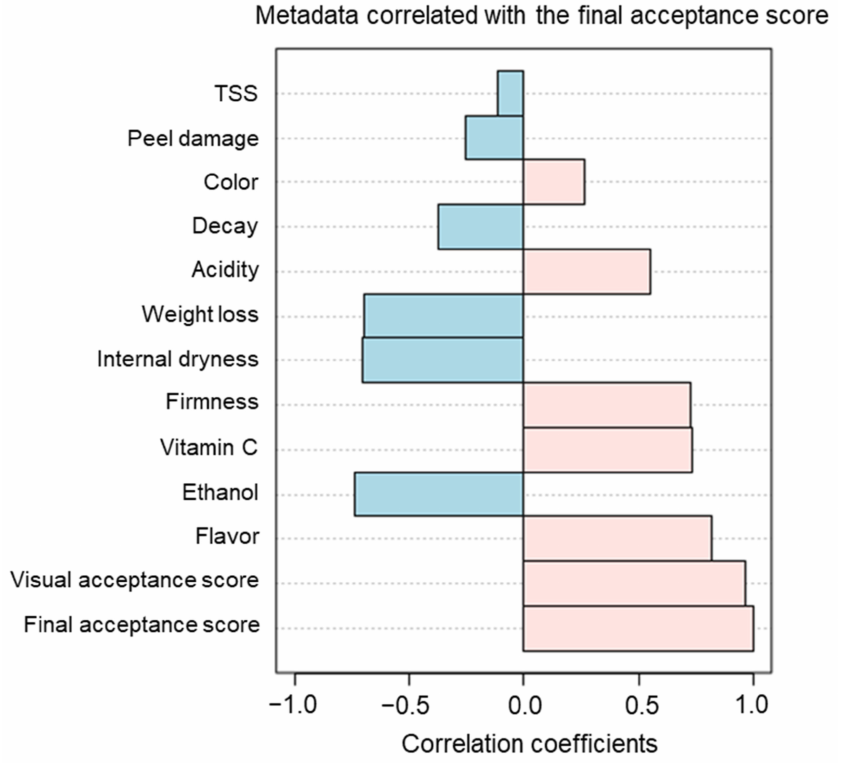
Figure 7. Pearson correlations between the various fruit quality parameters and the final acceptance scores of ‘Valencia’